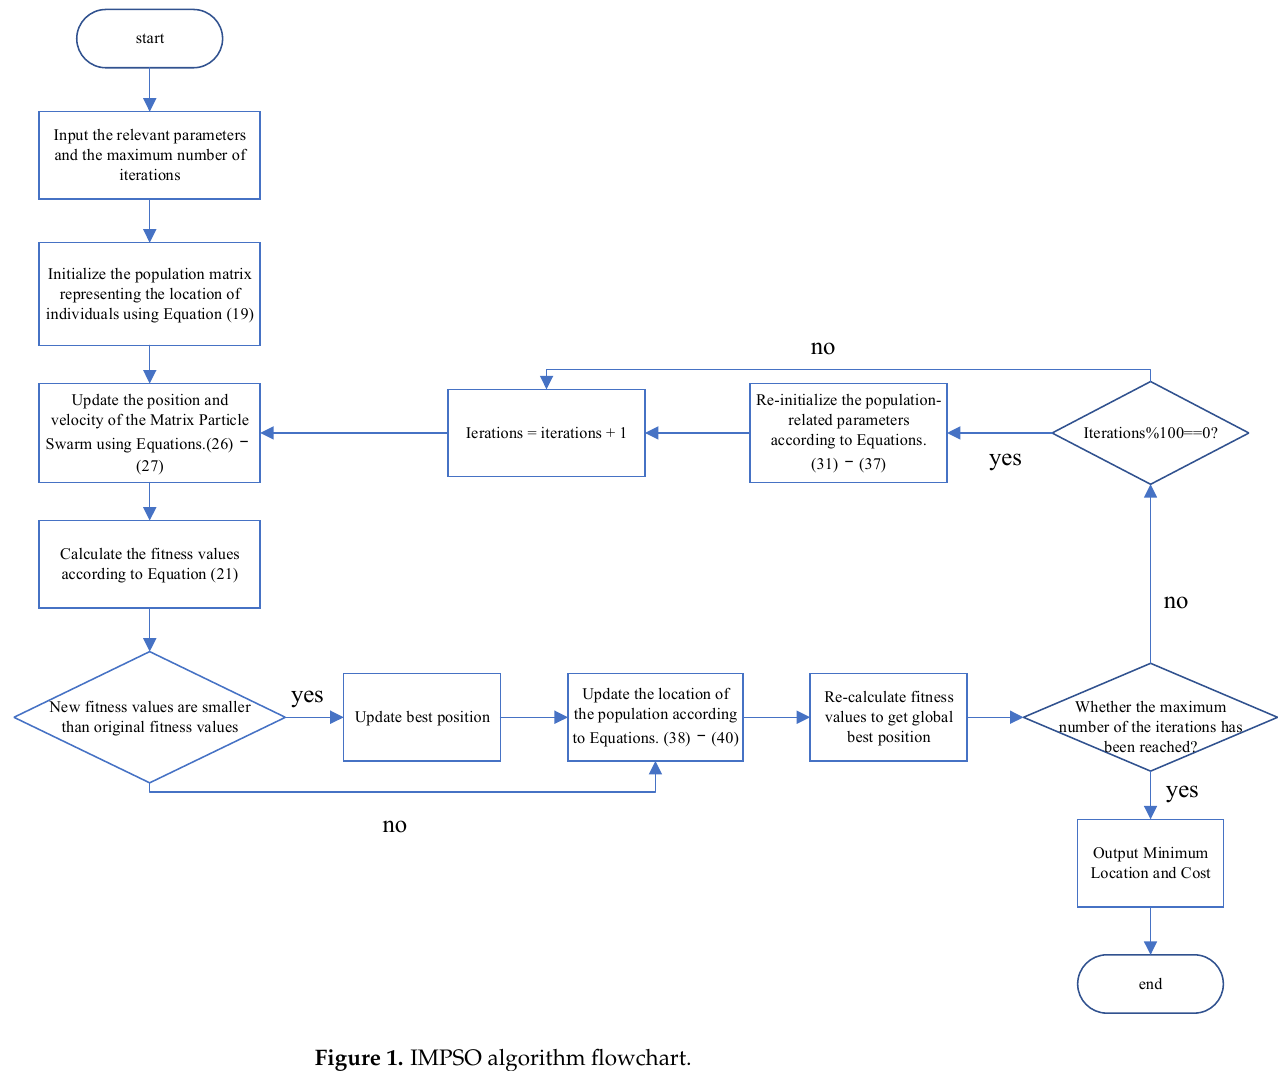
Table 2. Related parameters in IMPSO algorithm .